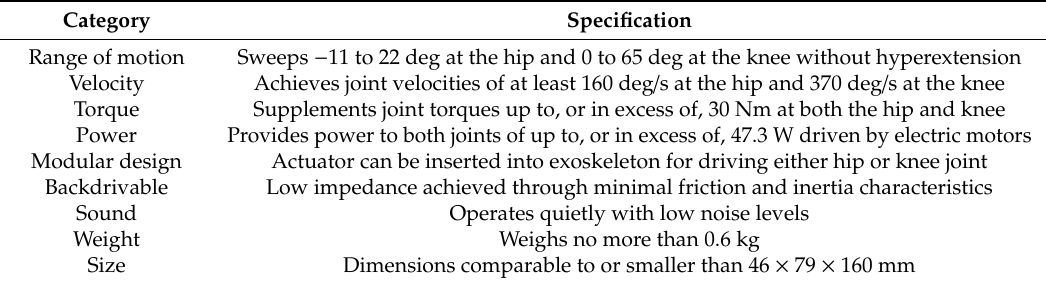
Table 3. Summary of the design specifications for the pediatric exoskeleton joint actuator.